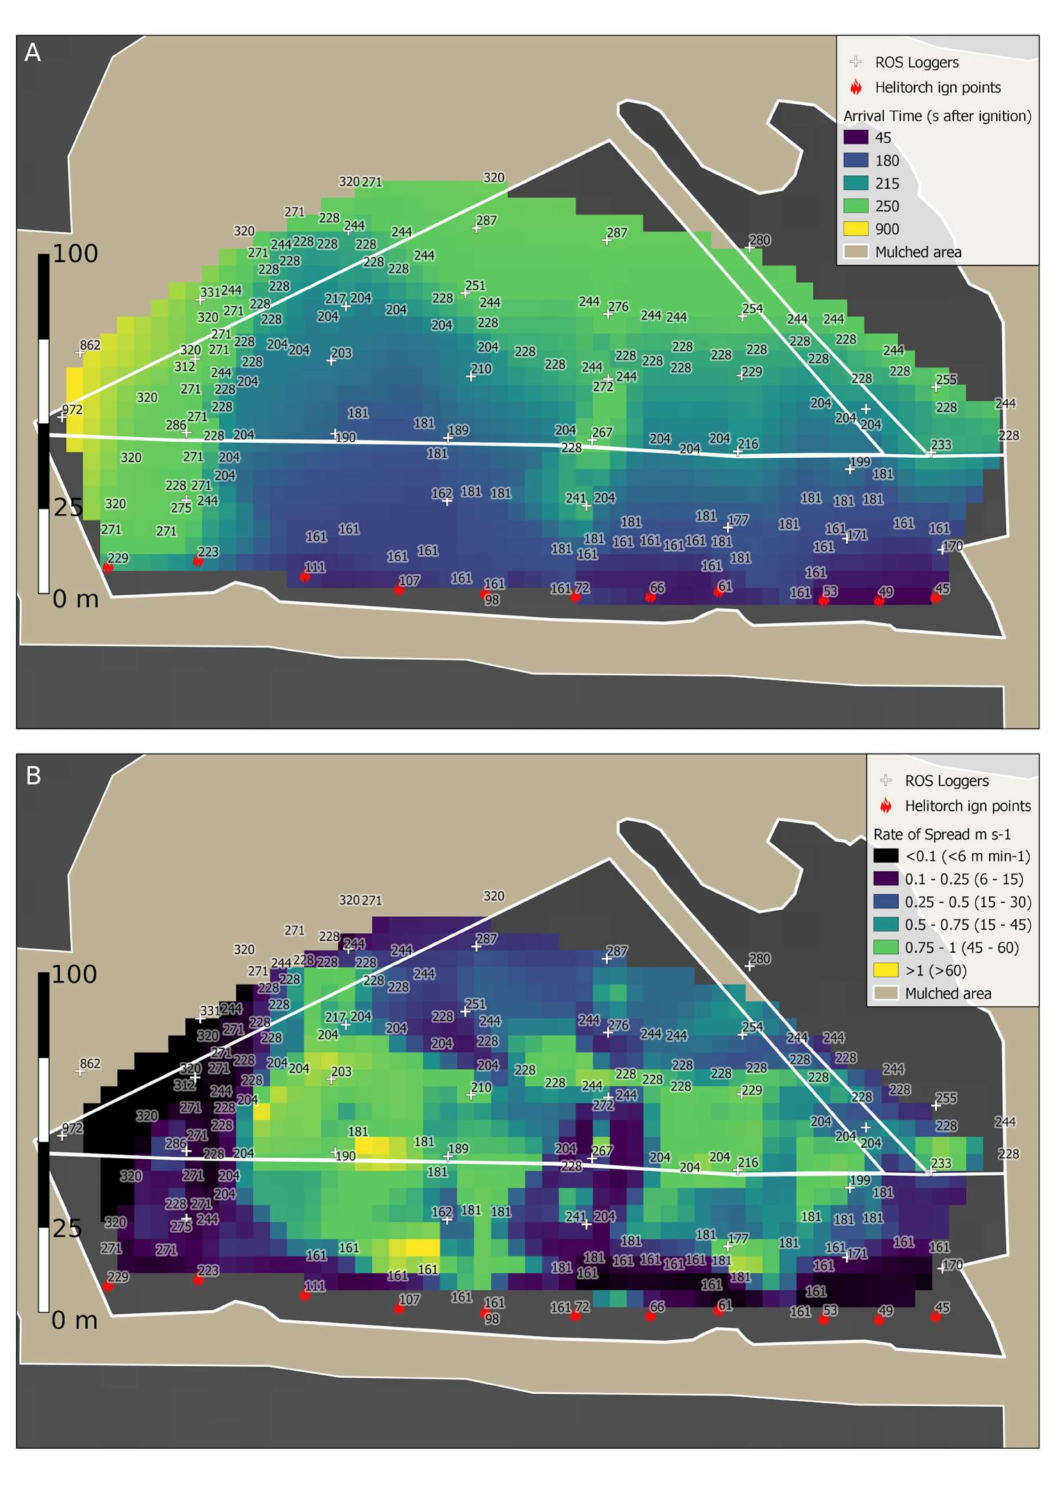
Figure 5. Interpolated fire arrival time (Panel A) and fire rate of spread (Panel B) from a combination of in-fire measurements and oblique photography. The southern polygon containing the ignition points is the control stand, and all areas past the east-west line 50 m into the control were treated. The pre-existing cutline running NW through the eastern treated area is also shown. Numbers correspond to points of known fire arrival time (seconds after aerial ignition commenced). Note that a fully continuous colour ramp from [39] is used for this and all figures, with mid-point colours of ranges shown in the legend for